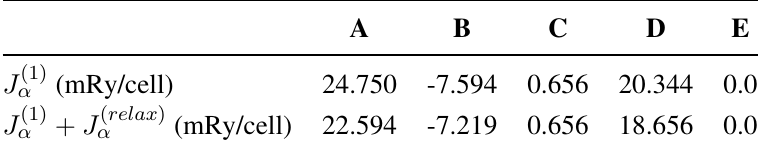
(mRy/cell) calculated for the Fe V alloy α 0 . 5 0 . 5 for the experimental lattice α